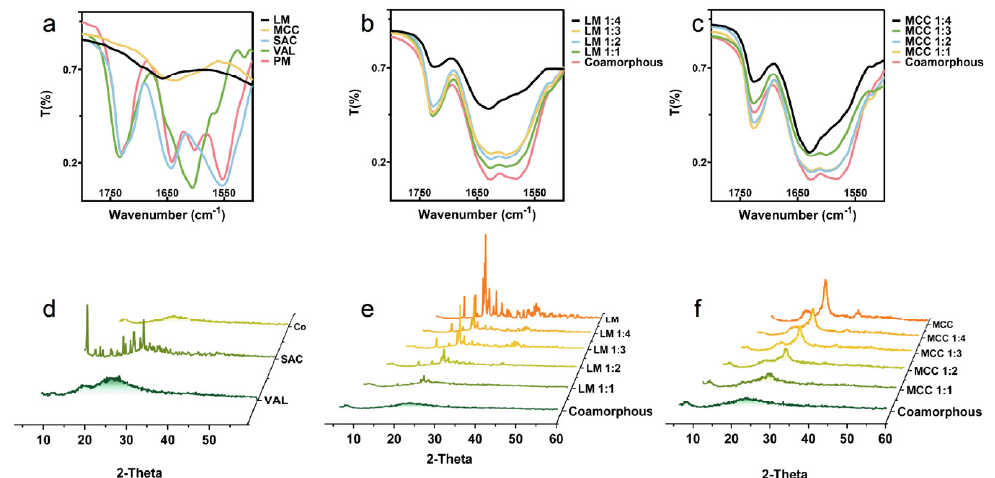
Figure 2. Characterization of spray-dried amorphous SDs, single drugs, and inert carriers. ( a – c ) Fourier transform infrared spectroscopy (FTIR) spectroscopy; ( d – f ) powder X-ray diffraction patterns.